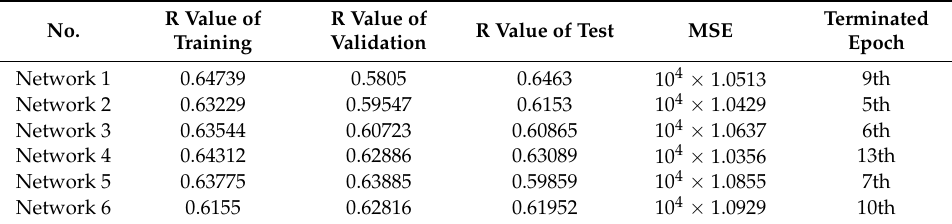
Table 9. The performances of the ANNs with different condition in hidden layer.